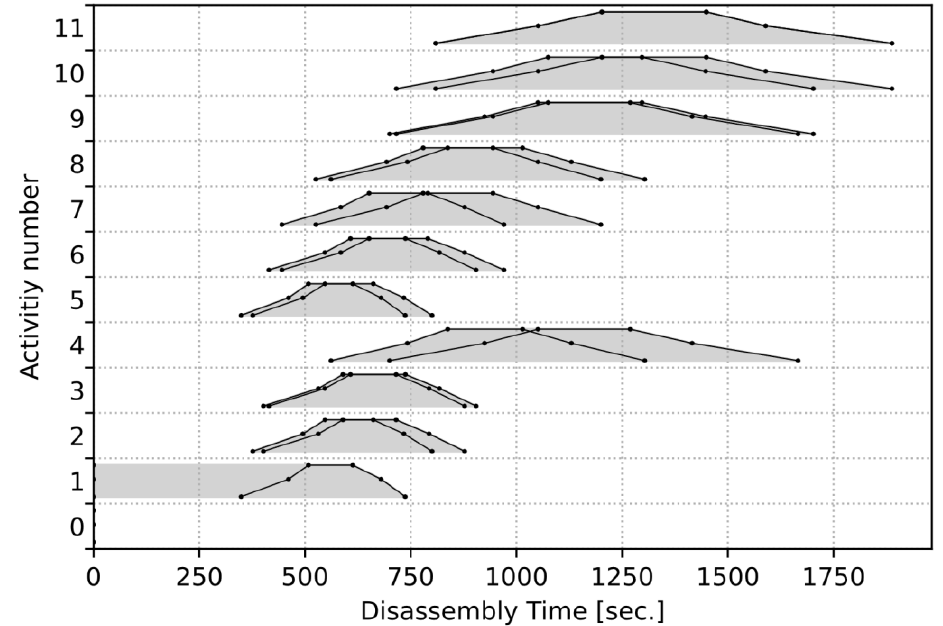
Figure A2. Scenario “One worker” resulting fuzzy Gantt chart for each disassembling step and Figure A2. “ ” fuzzy Gantt chart for each disassembling step and cal- Energies 2022 , 15 , x FOR PEER REVIEW ) and fuzzy finish time ( (cid:101) t f ) . calculated their fuzzy start time ( (cid:101) t s culated their fuzzy start time ( 𝑡 ̃ 𝑗𝑠 ) and fuzzy finish time ( 𝑡 ̃ 𝑗𝑓 ) . j j